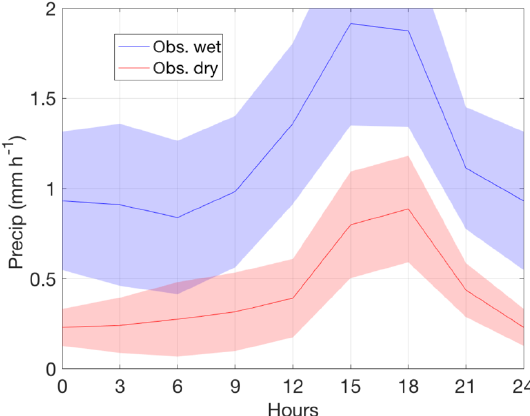
Figure 2. Diurnal cycle in local time of dry-season (red) and wet- season (blue) observations of precipitation (Precip) at K34, near Manaus, along with their standard deviation averaged across years